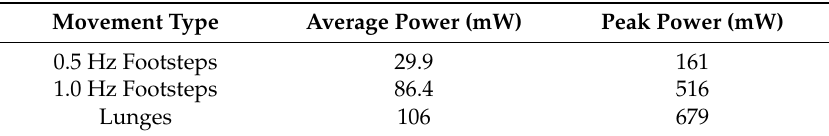
Table 1. Power generated for various modes of